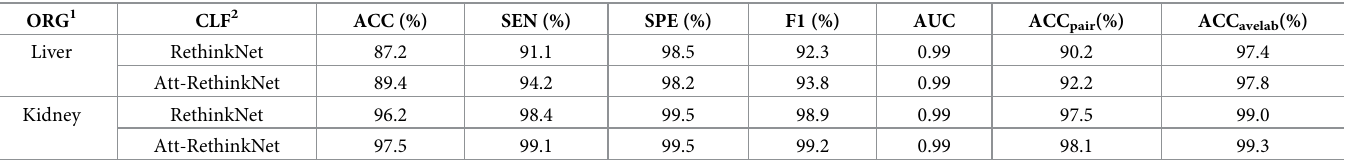
Table 4. Comparison between the proposed method and the baseline model.